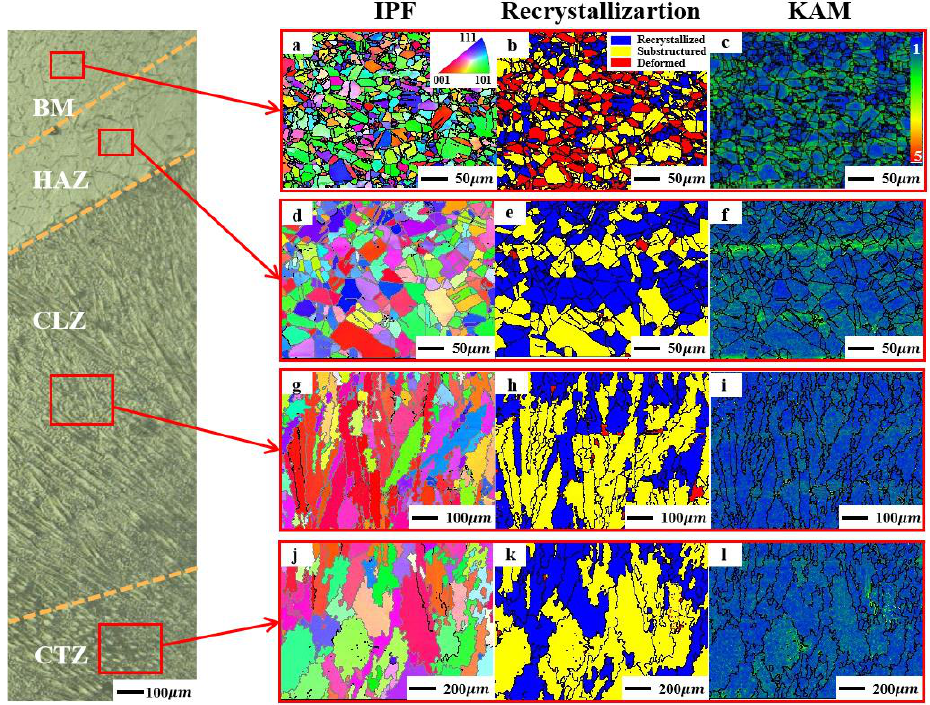
Figure 4. The IPF, recrystallization diagram, and kernel average misorientation (KAM) diagram of different areas of the sample after 720 mA electron beam scanning: ( a – c ) BM, ( d – f ) HAZ, ( g – i ) CLZ, ( j – l ) CTZ.